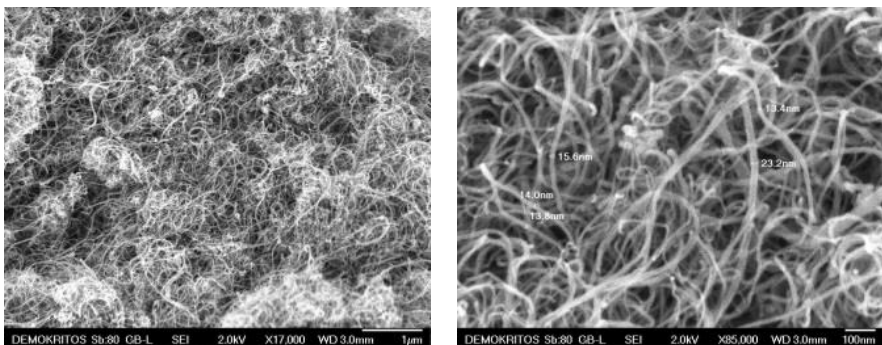
Figure 2. SEM images of multi-walled carbon nanotubes (MWCNTs). Total pore volume, specific surface area, and pore size distribution characteristics were determined using liquid nitrogen adsorption measurements at 77 K. Prior to measurement, the samples were subjected to degassing overnight at 250 °C under high vacuum (10 −6 mbar). The shape of the adsorption isotherm (Figure 3) was classified as type II with a close to type H3, mild adsorption hysteresis loop according to IUPAC classification [28]. The isotherm was similar to typical N 2 isotherms and hysteresis for CNTs that are mesoporous materials with broad pore size distribution, according to the Kelvin equation, and plate-like particles aggregated into slit-shaped pore structures. The calculated specific surface area (SSA) was 220 m 2 /g according to the BET (Brunauer–Emmett–Teller) method.